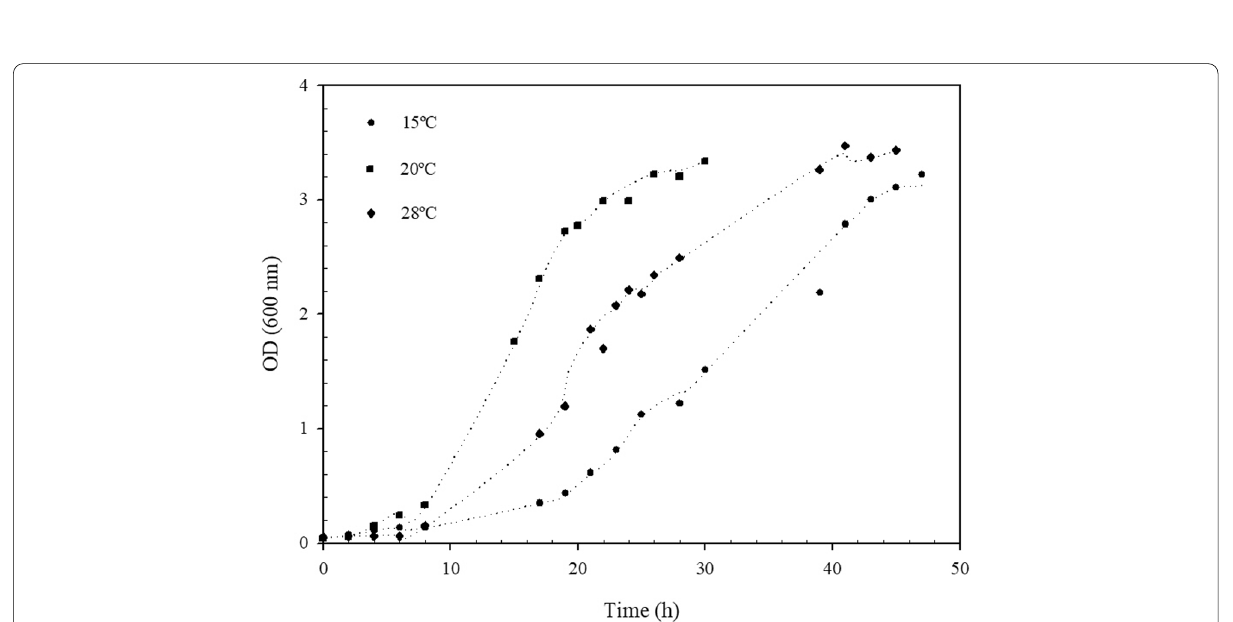
Fig. 2 Effect of temperature on Pedobacter sp. 3.14.7 growth on Nutrient Broth medium; cell growth was monitored by measuring its optical density at 600